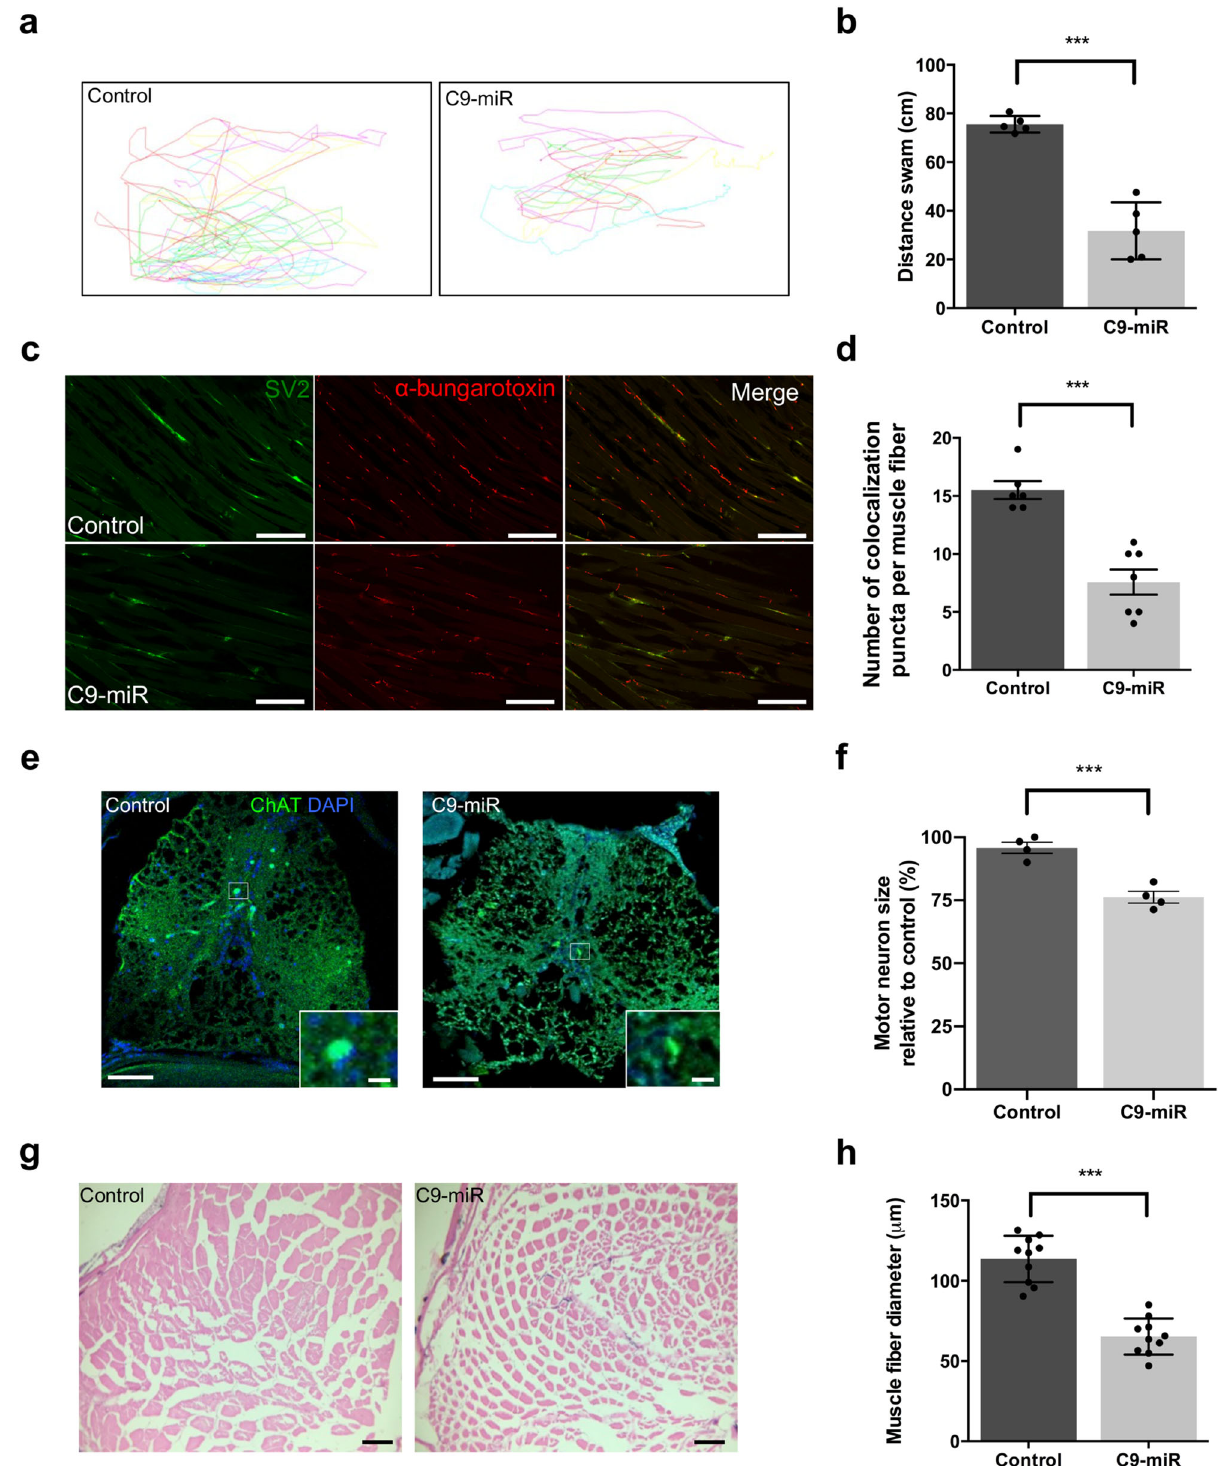
Fig. 5 Adult zebra fi sh C9-miR display muscle atrophy, smaller motoneurons and behavioural de fi cits. a Representative traces of swimming activity of fi ve adult controls and C9-miR fi shes (12-month old) during 30 s (left panel). b C9-miR fi sh exhibit behavioural de fi cits (right panel) ( n = 5, *** p < 0.0001, Student ’ s t test). c Adult 12-month-old NMJs were examined in trunk section by co-immunostaining SV2 (green) and α -bungarotoxin (red). d Quanti fi cation of the colocalizing presynaptic and postsynaptic clusters at NMJ in adult (12-month old) wild-type control ( n = 6) and C9-miR fi sh ( n = 7) (*** p < 0.0001, Student ’ s t test). e ChAT staining in adult zebra fi sh spinal cord . f Large (mature) motor neurons (inset in e ; scale bar = 10 μ m) are reduced in size in C9-miR compared to controls ( n = 4; *** p < 0.0001, Student ’ s t test). g Examination of adult zebra fi sh muscle myotomes by haematoxylin and eosin staining. h C9-miR fi sh display a smaller diameter of muscle fi bres compared to controls ( n = 10; *** p < 0.0001, Student ’ s t test). Data are presented as mean ± SEM. Scale bar = 50 μ m. n represents the number of sections from three adult fi sh per